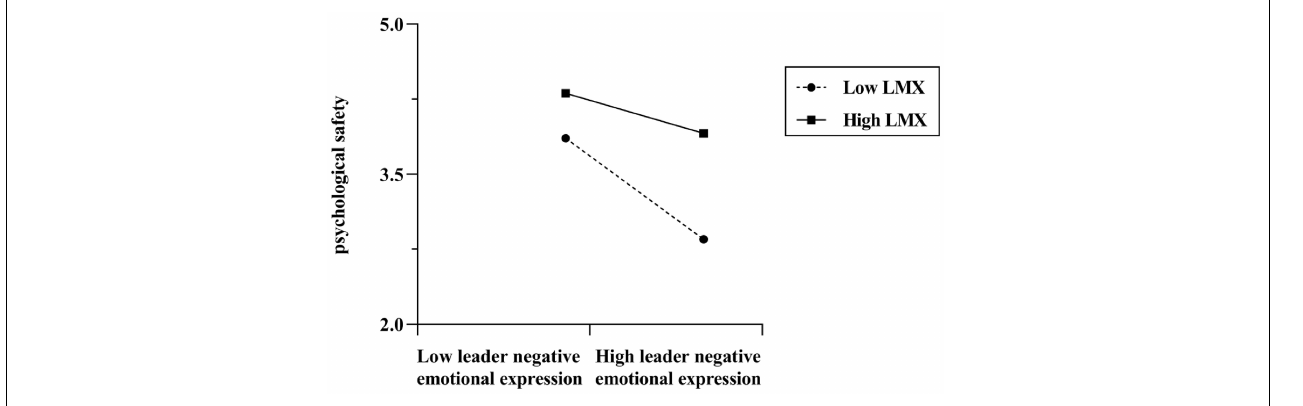
FIGURE 2 | Moderating effect of LMX on the relationship between leader negative emotional expression and psychological safety.